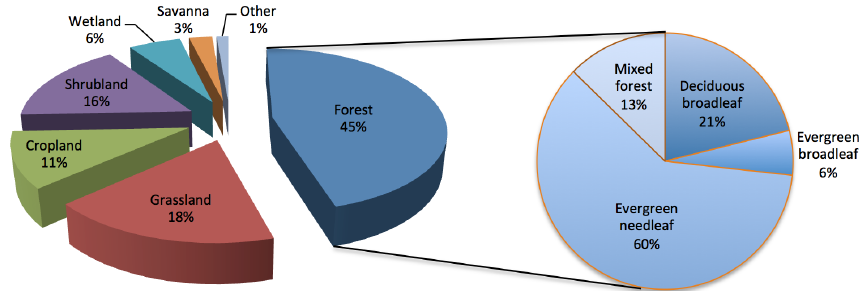
Fig. 2. Ecosystem representation, according to IGBP ecosystem classifications, of the AmeriFlux network based on registered sites as of January